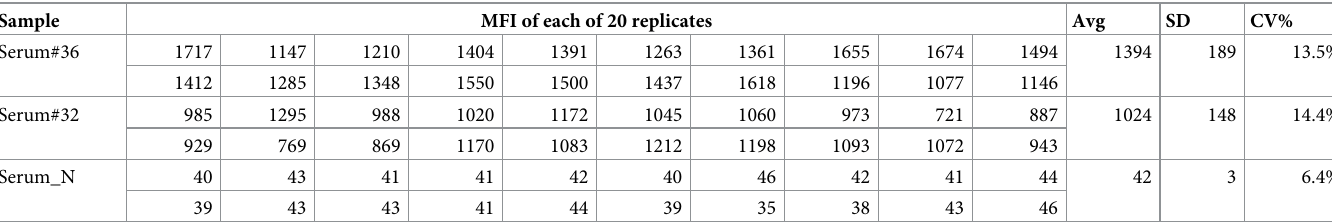
Table 4. Intra-assay reproducibility.